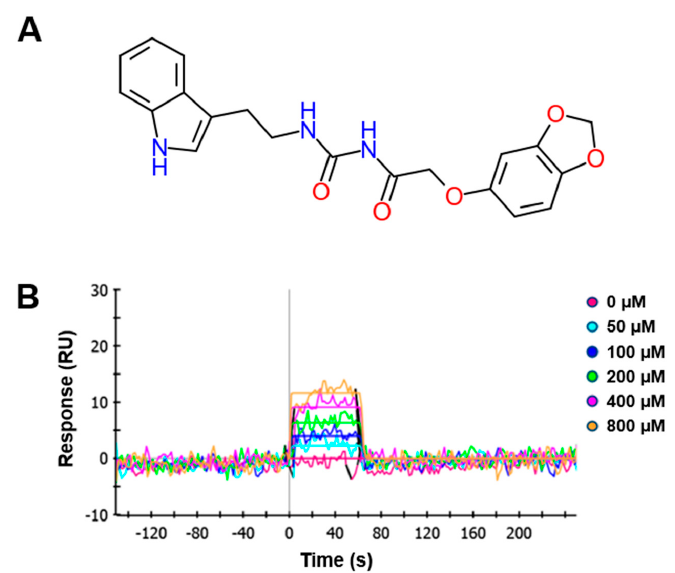
Figure 1. Properties of a novel talin modulator, KCH-1521. ( A ) Chemical structure of N -((2-(1 H -indol-3-yl)ethyl)carbamoyl)-2-(benzo[ d ][1,3]dioxol-5-yloxy)acetamide (KCH-1521); ( B ) Representative sensorgram from surface plasmon resonance (SPR) analysis of talin-KCH-1521 binding. The binding of KCH-1521 with talin fixed on a sensor chip was observed in a dose-dependent manner with a K D value of 3.01 × 10 − 4 M. RU, resonance units.